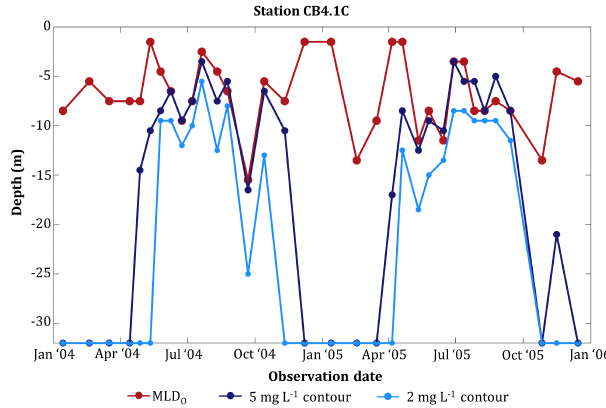
Figure 12. Time series of observations of dissolved oxygen and MLD O contours at Station CB4.1C for 2004 and